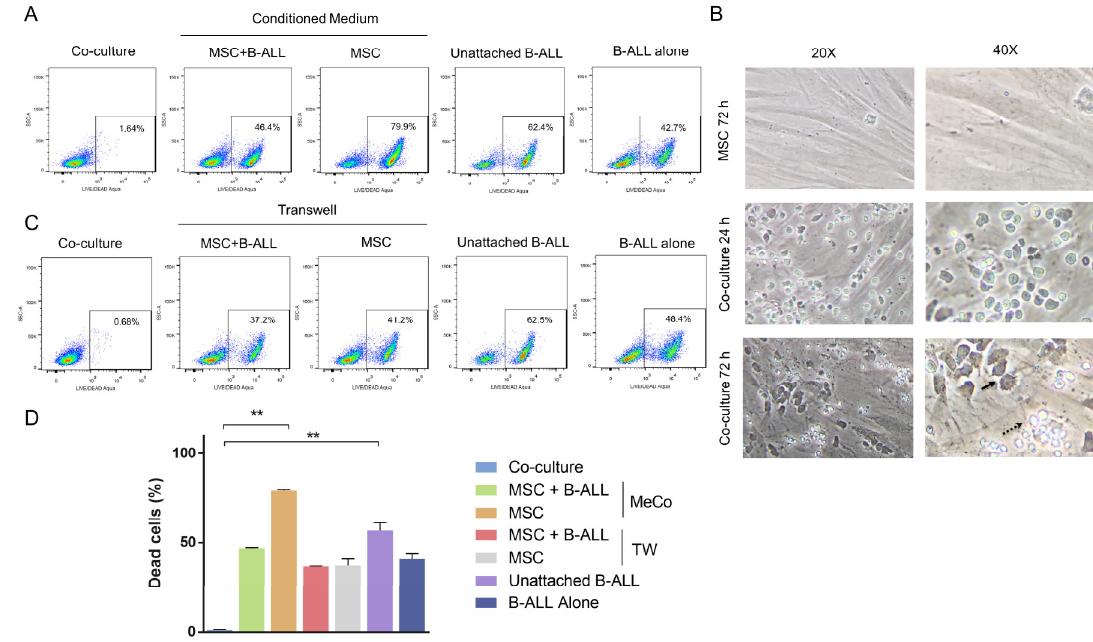
Figure 5. Cell to cell interaction between MSC and leukemic cells is indispensable for B-ALL cell survival. ( A ) B-ALL cells viability was assessed by flow cytometry after exposure for 24 h to fresh conditioned media obtained from a 72 h co-culture of B-ALL and MSC or from a culture of MSC alone. Control of leukemic cells in direct contact with MSC support showed the highest percentage of viability (left panel, Co-culture). Percentages in squares correspond to CD19 + B-ALL cells positive for LIVE / DEAD Aqua staining. The gate was established respect to the control corresponding to the unlabelled co-culture. ( B ) Changes in the appearance in the leukemic cell population were observed in the co-cultures from which the conditioned media were obtained. Unattached leukemic cells looked refringent (dotted arrow) while adherent ones were particularly opaque (solid arrow). Representative microphotographs are shown at the indicated magnifications. ( C ) Survival of B-ALL cells in the presence of soluble factors produced by the co-culture or MSC alone was evaluated in a Transwell system. B-ALL cells alone or B-ALL cells and MSC in direct contact were used as controls. Analysis was done as explained above. ( D ) Quantification of LIVE / DEAD Aqua positive B-ALL cell populations (dead cells) for each of the experiments described in A and C. Data are expressed as mean ± SEM obtained from two independent experiments ( p values: nonparametric one-way ANOVA. ** p <